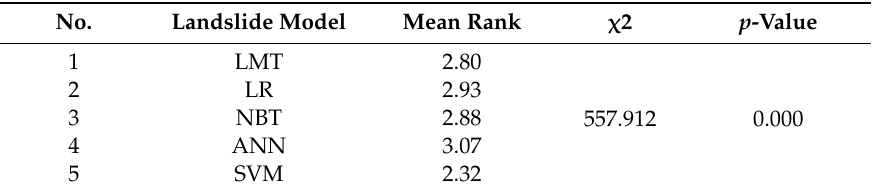
Table 2. Performance of the five landslide machine learning models using Wilcoxon signed-rank test (two-tailed).